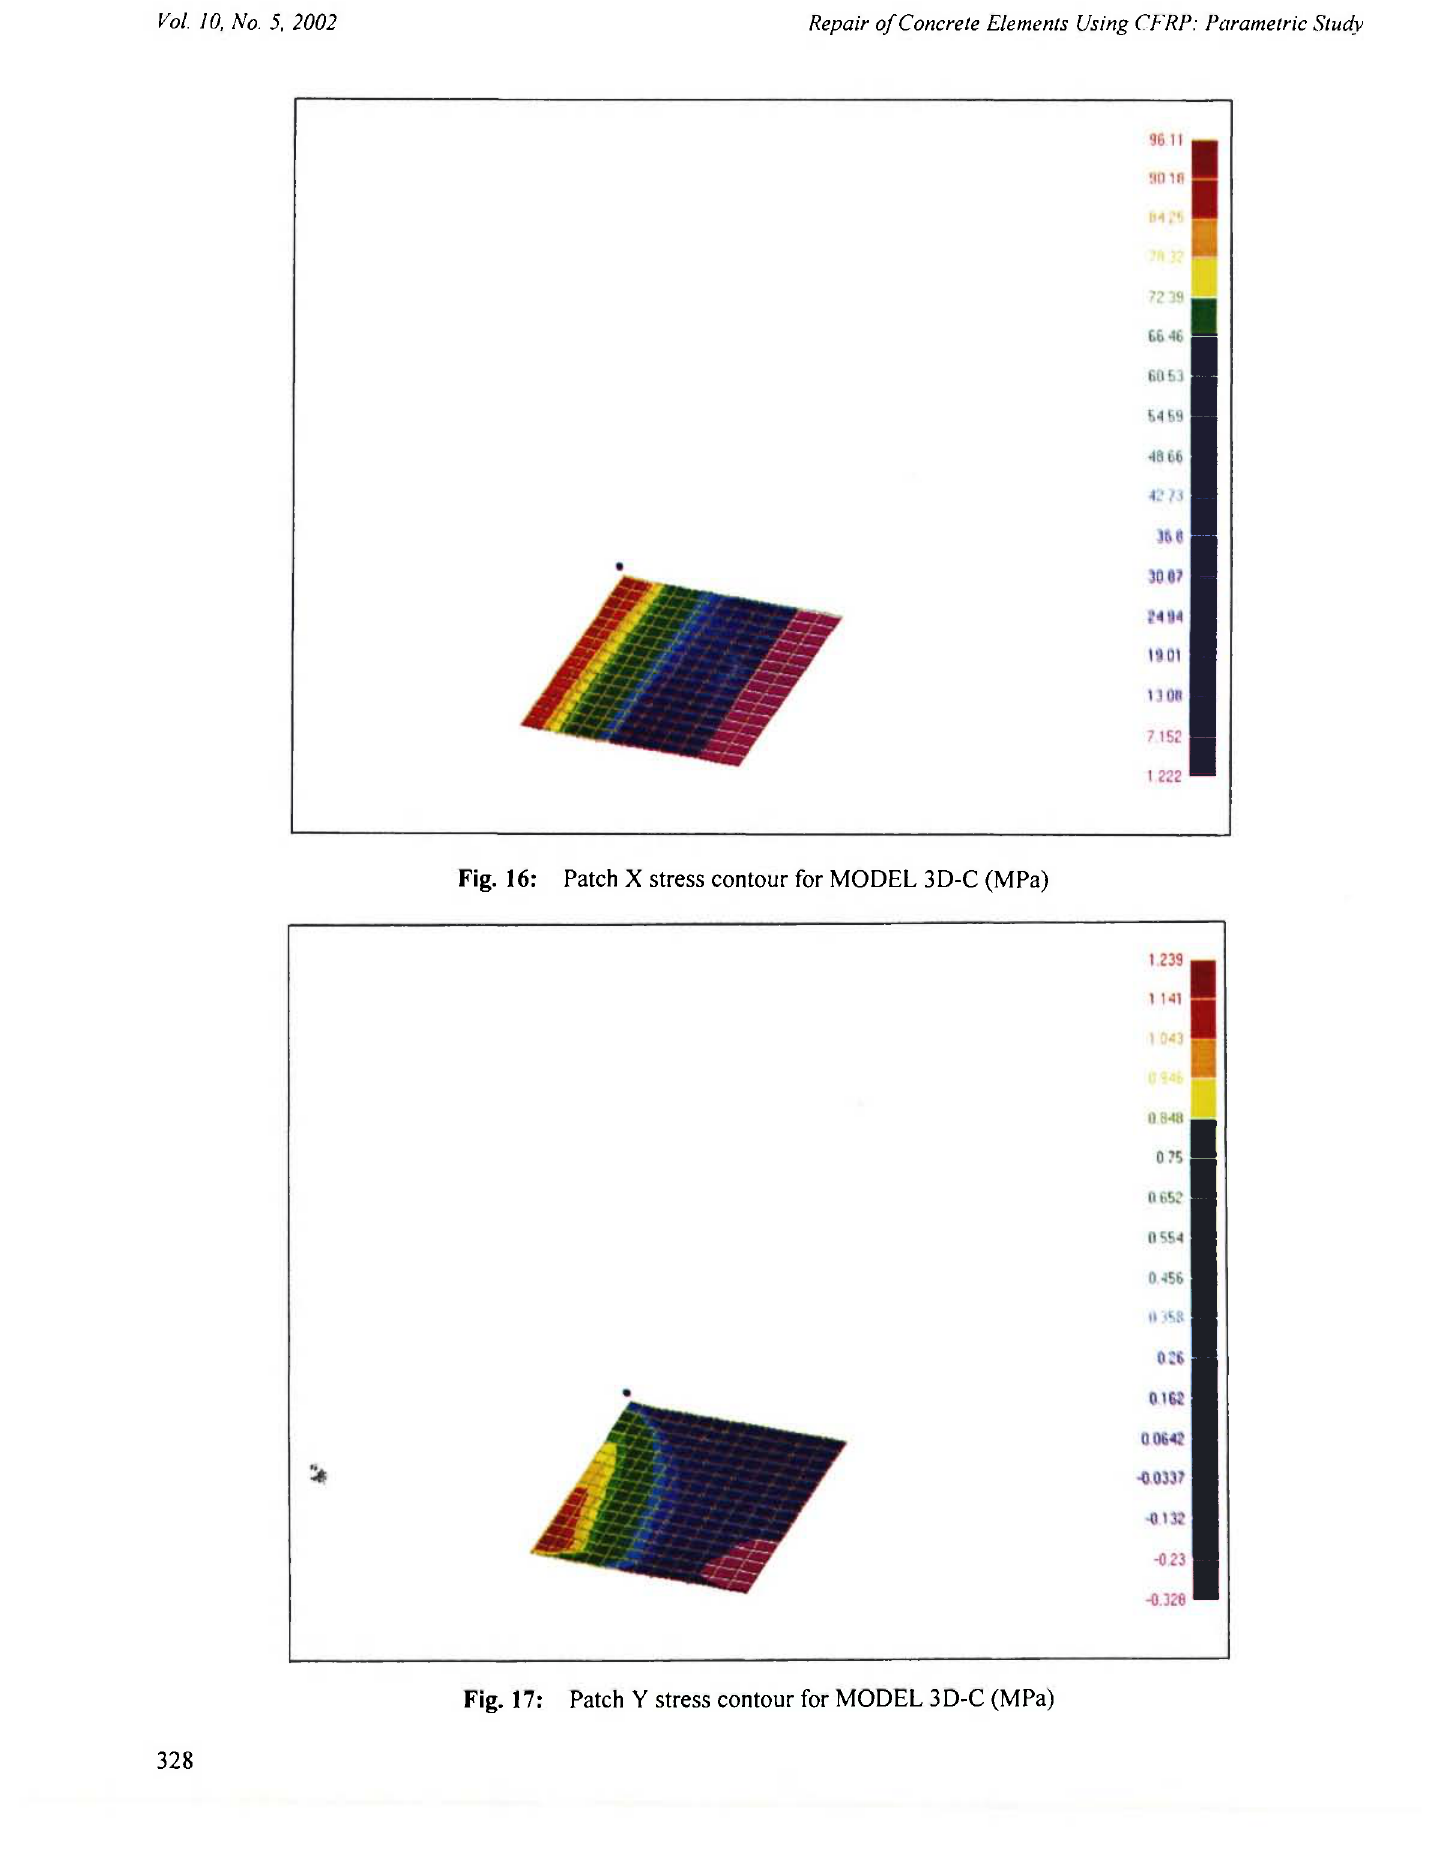
Fig. 16: Patch X stress contour for MODEL 3D-C (MPa)